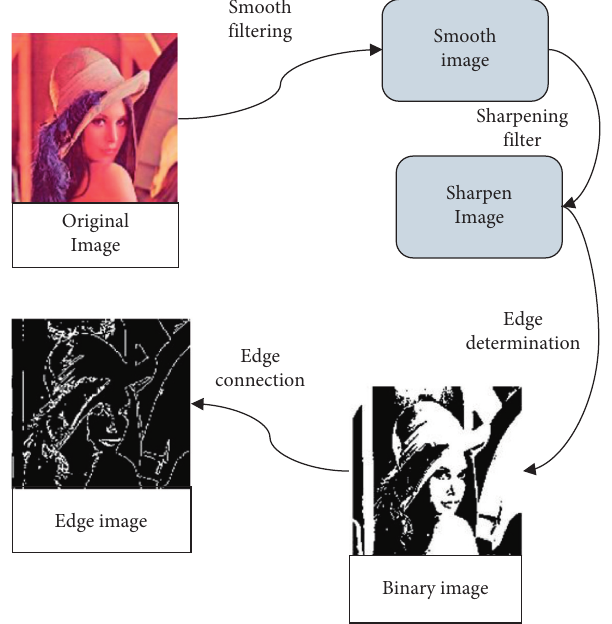
Figure 1: Digital image processing